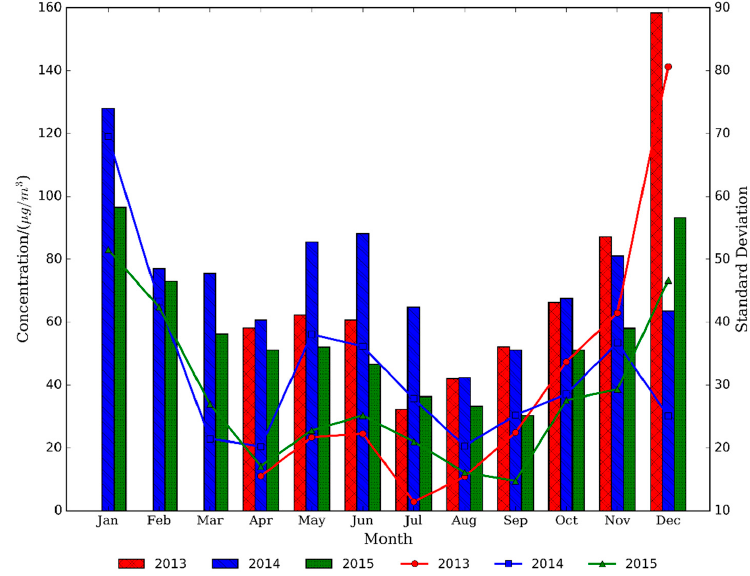
Figure 4. Monthly variation of PM 2.5 concentrations in Nanjing. The bar represents PM 2.5 concentrations and the line means standard deviation. and the line means standard